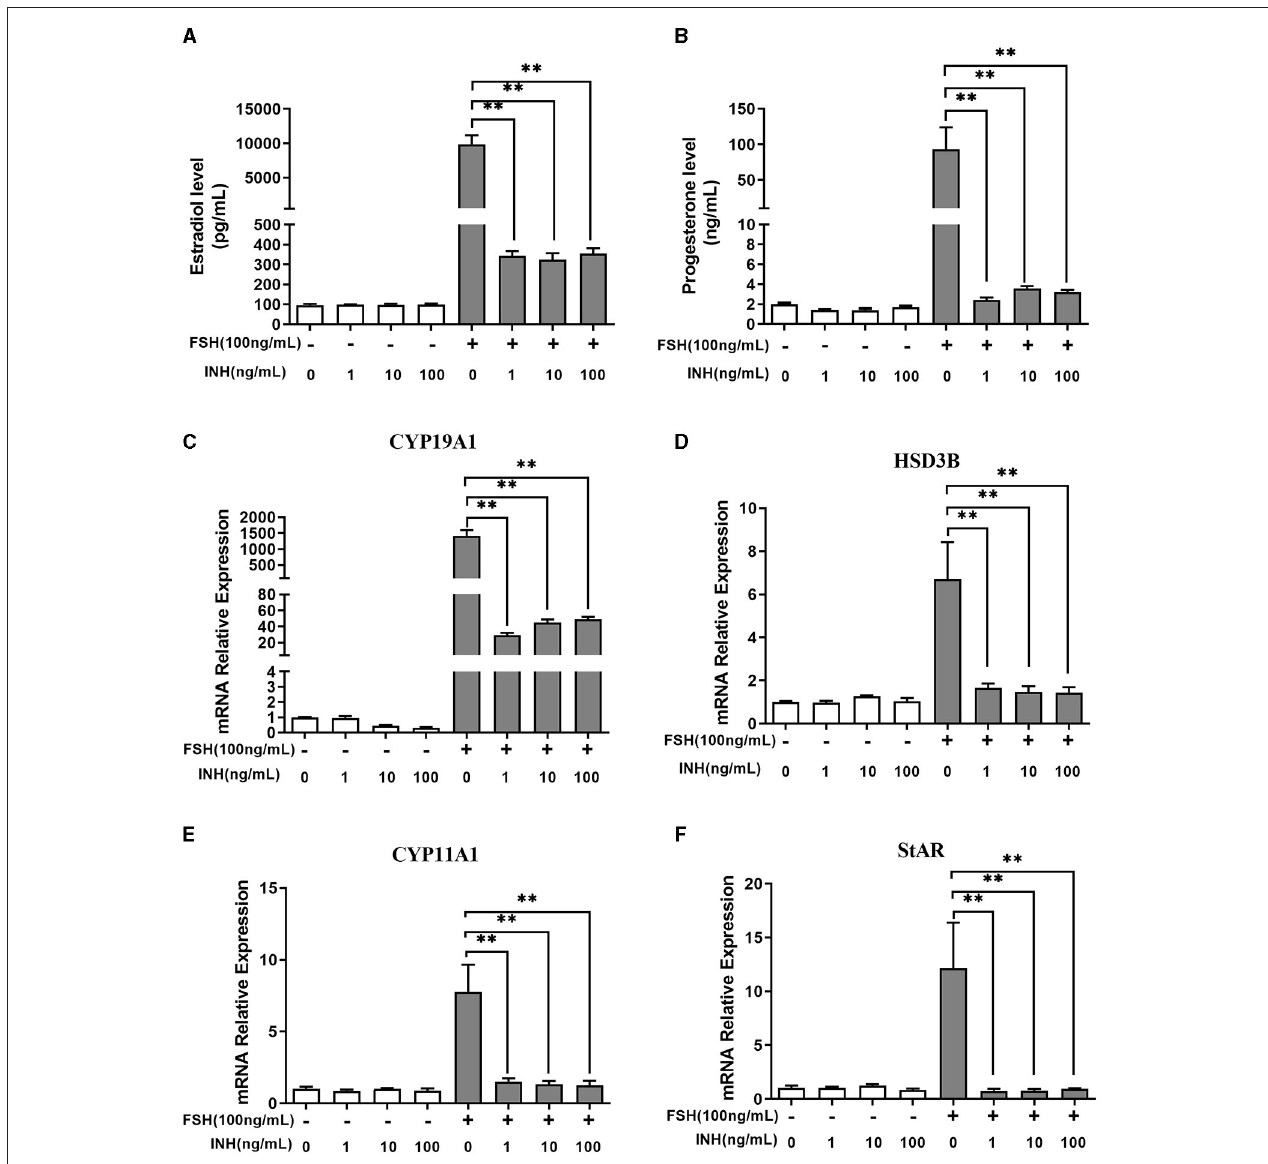
FIGURE 1 | Effects of Inhibin A on the biosynthesis and secretion of estradiol and progesterone by primary granulosa cells. (A,B) Estradiol and progesterone production after treatment with increasing concentrations of INHA in the presence or absence of 100ng/ml of follicle-stimulating hormone (FSH). (C–F) Relative expression of CYP19A1 , HSD3B , CYP11A1 , and StAR transcripts after treatment with increasing concentrations of INHA in the presence or absence of 100ng/ml of FSH. Data are presented in mean ± SEM. ** p < 0.01 between the indicated